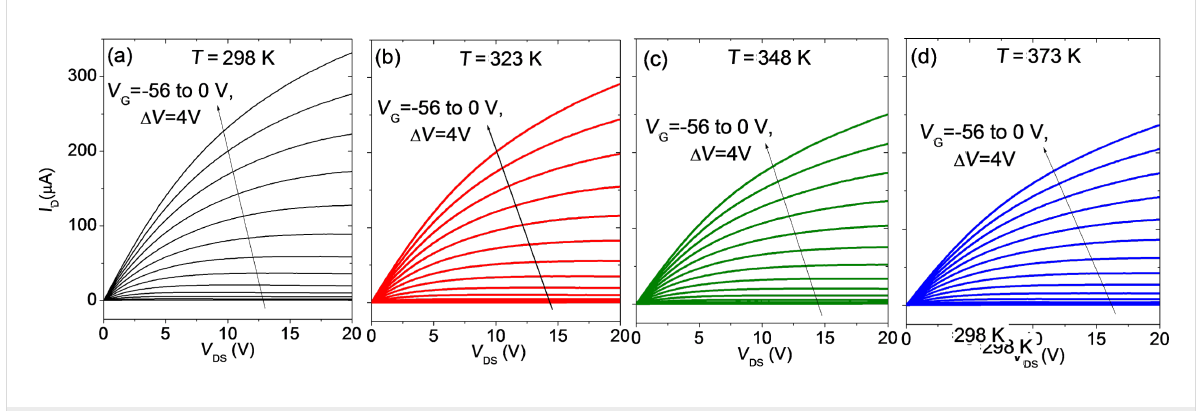
Figure 6: Output characteristics I D − V DS for different gate bias values from − 56 to 0 V at different temperatures: (a) T = 298 K, (b) T = 323 K, (c) T = 348 K and (d) T = 373 K.